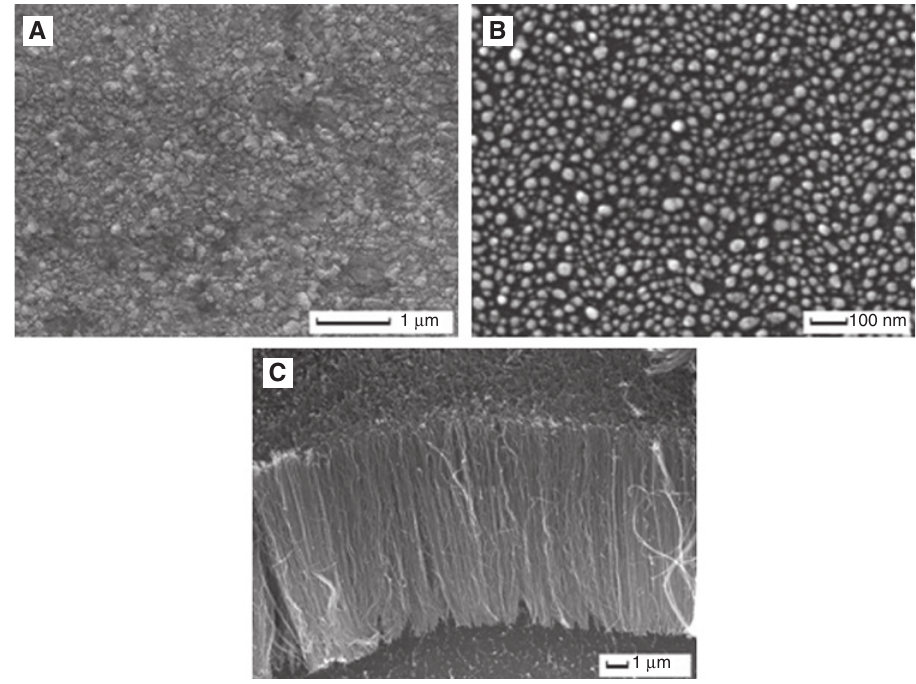
Figure 1: SEM images of (A) untreated substrate, (B) treated substrate, and (C) the grown